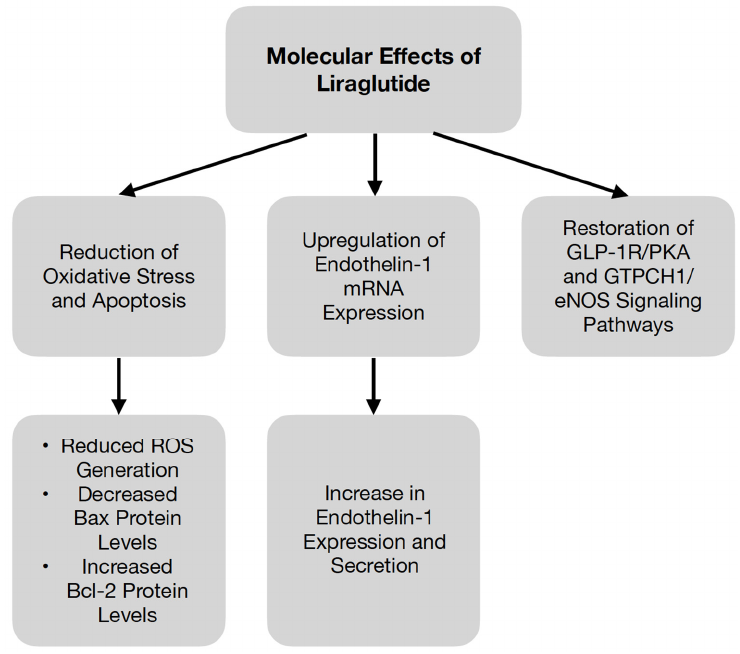
Figure 3. Molecular e ff ects of liraglutide [24].